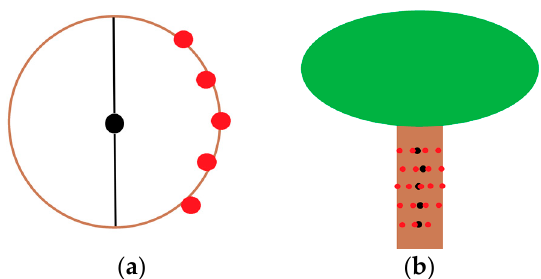
Figure 4. Each of the 16 laser channels was treated separately. ( a ) Illustrates points from the same laser channel reflecting on a tree stem. The red points have all shorter observation distance increment than the given threshold and forming a group of tree stem points. These points are used to estimate a tree stem center point and diameter marked with black color. ( b ) Illustrates five different groups of tree stem points with the center point marked as a black point and the red points are the laser points. If the number of consecutive tree stem center points were five or more the center points were accepted as a tree and used in step 9 illustrated in Scheme 1.